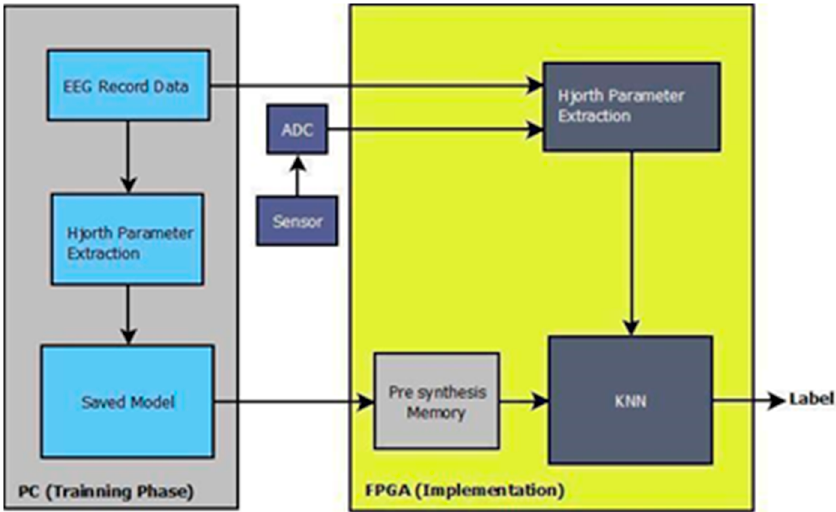
Figure 2 . System blocks consist of three main parts: PC for the training stage, digital EEG as